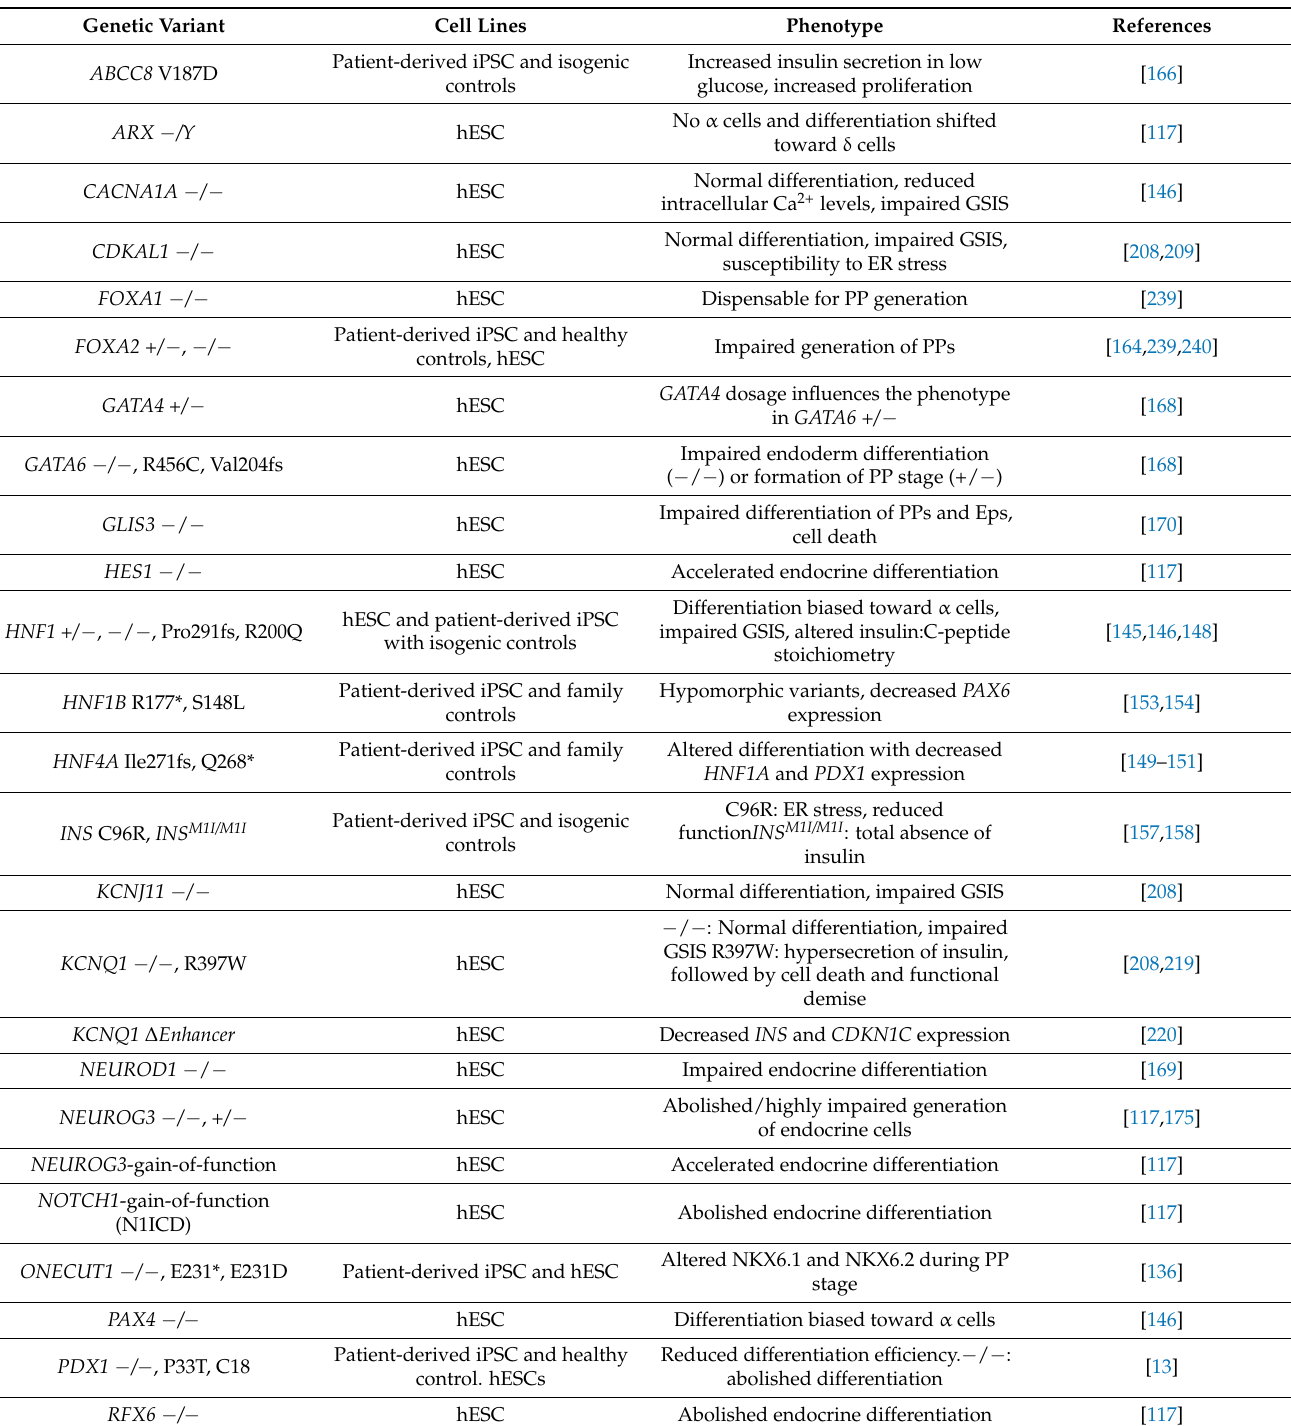
Table 1. Summary of stem cell lines used to study genetic variants and their impact in en- docrine development and β cell function. Variants listed are loss-of-function/hypomorphic unless stated